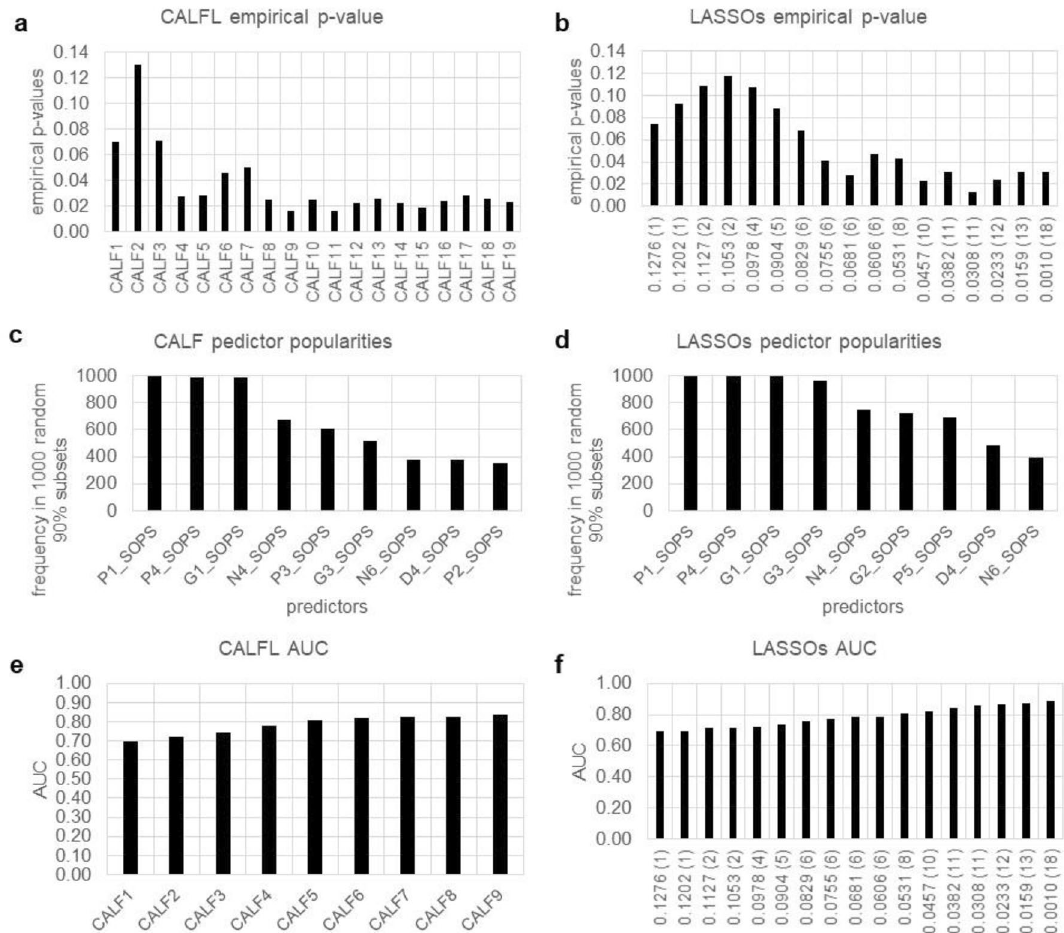
Figure 3. Comparison of CALF and LASSO logistic regression results for Example 3. ( a ) CALF4 empirical p-value is 0.027 while CALF9 yields 0.019. Simplicity favors CALF4. ( b ) Noting the different vertical scale, the lowest empirical p-value 0.065 for LASSO occurs with s = 0.15 and only one predictor—a mere trend. ( c ) CALF has a strong cliff at three predictors, but empirical p-values of recommend CALF4. ( d ) LASSO has a strong cliff with four predictors but an unacceptable empirical p-values for two or more predictors. ( e ) CALF4 has AUC 0.777 while ( f ) LASSO only exceeds that at LASSO.068 by using six predictors and